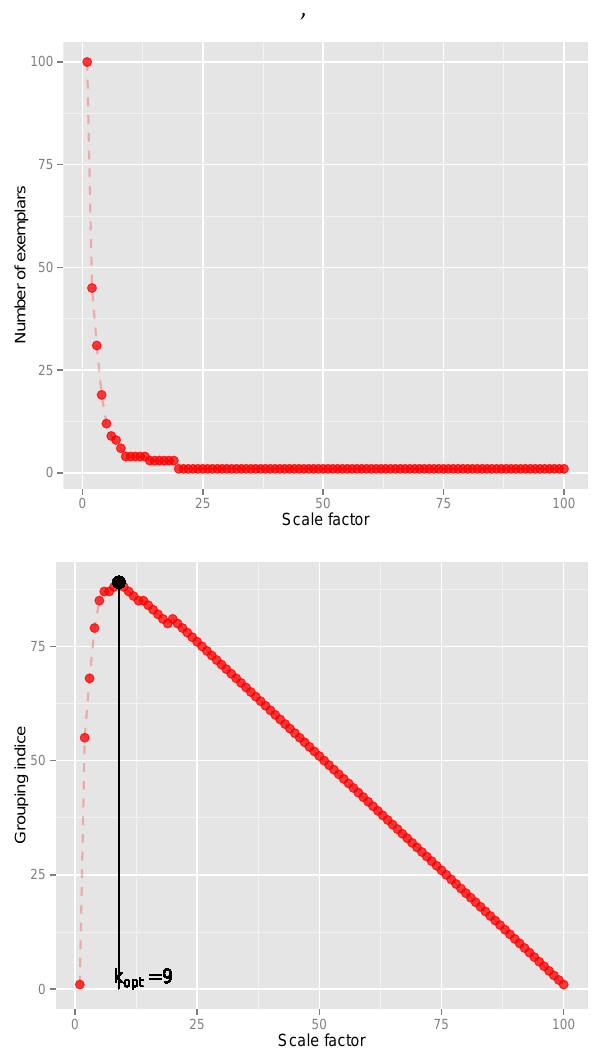
Figure 5. Number of Exemplars (top) from Figure 1 (A) dataset and Scale Factor : The number of exemplar is smaller than 100 − ( k − 1) where k is the scale factor and 100 is the number of objects of the dataset. The grouping index (bottom) (the difference between 100 − ( k − 1) (gray line) and the number of extracted exemplars (red points)) is maximal when the scale factor is equal to 9 (black circle).